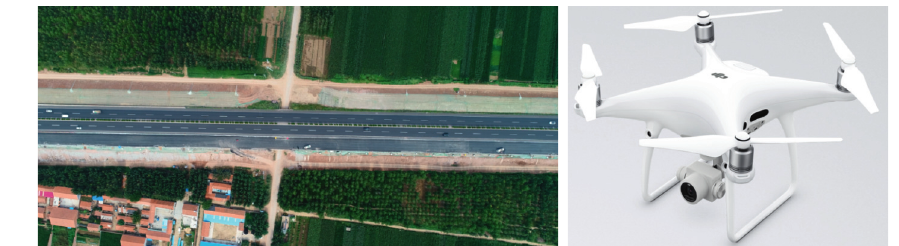
Figure 3: UAV collecting high-precision